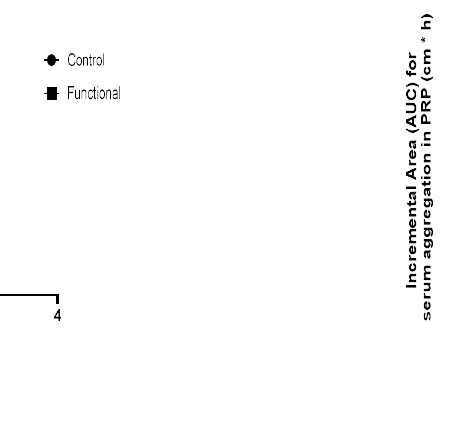
Figure 5. ( a ) Incremental changes in aggregation in PRP (cm) . ( b ) The incremental area under the curve (iAUC) for aggregation in PRP (cm × h).